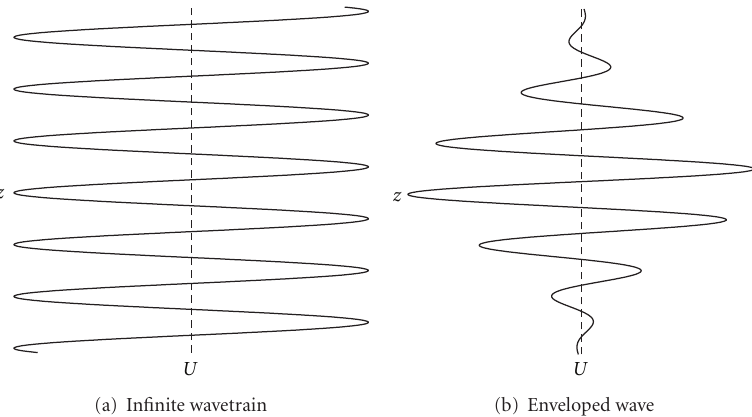
Figure 1: Inertia wave velocity profiles used in this study. The plotted variable is U ( z , t = 0) of (1), plotted here in nondimensional units. (a) G = 1. (b) G = e − z 2 /L 2